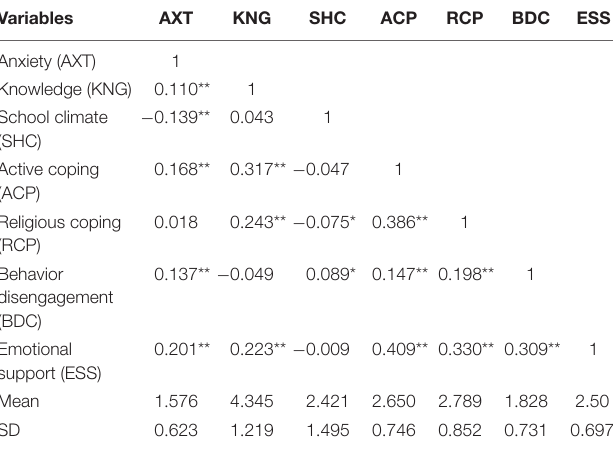
TABLE 1 | Correlations among variables, means, and standard deviations.